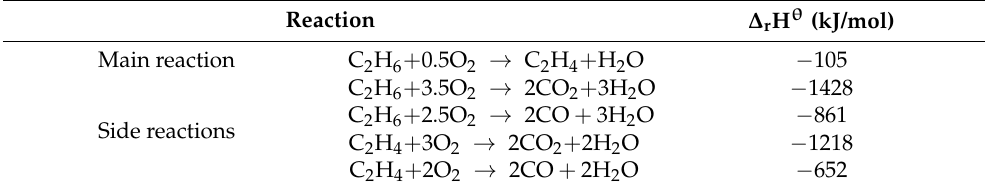
Table 2. The ODHE reaction network consists of selective oxidation of ethane to